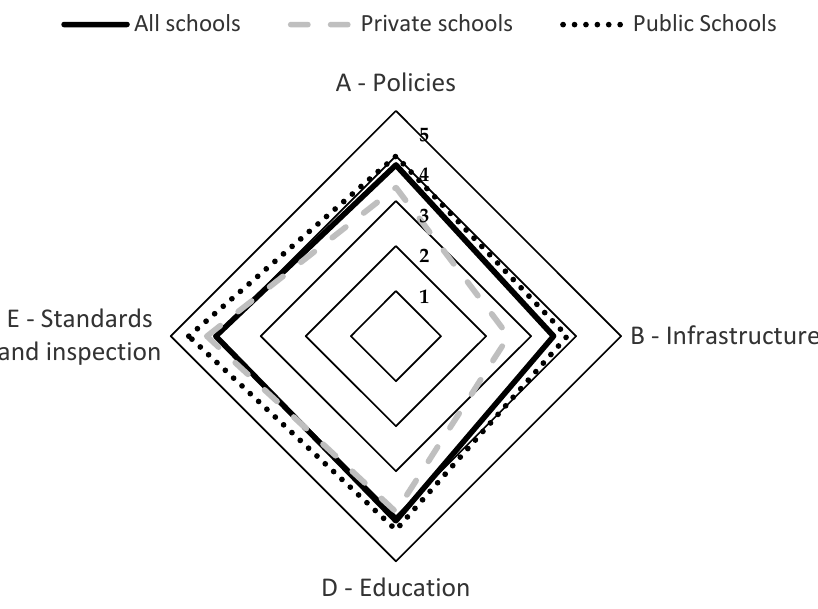
Figure 5. Overview of averages of all four elements.